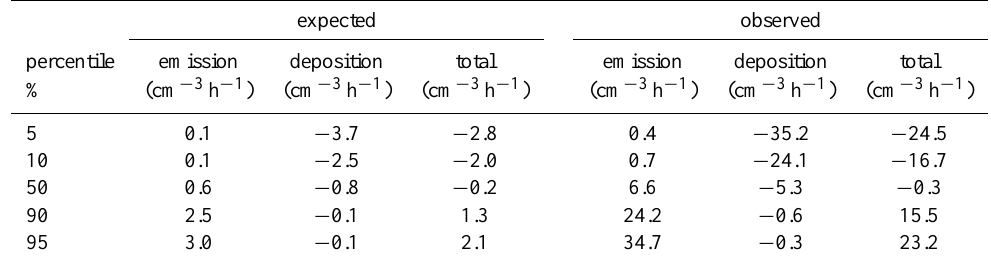
Table 2. Percentiles of changes in particle number concentration as expected from measured aerosol number fluxes assuming h eff = 25m and a 25% area fraction of open leads (expected), and as observed from direct particle number measurements (observed), during emission dominated periods, during deposition dominated periods, and for the entire measuring